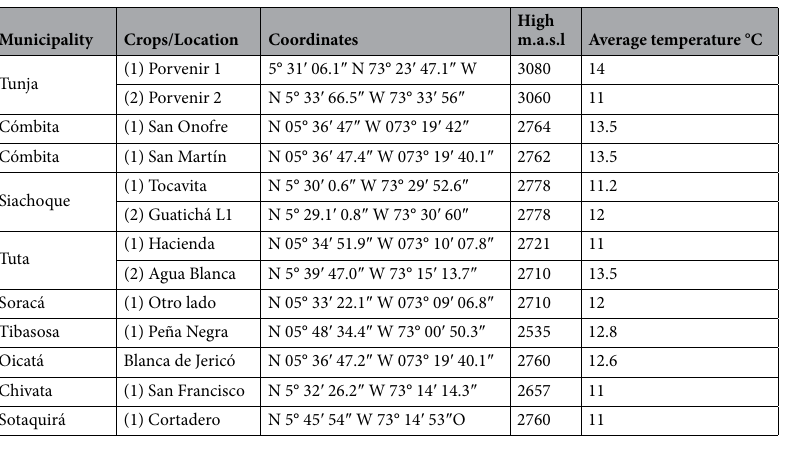
Table 3. Sampling zone